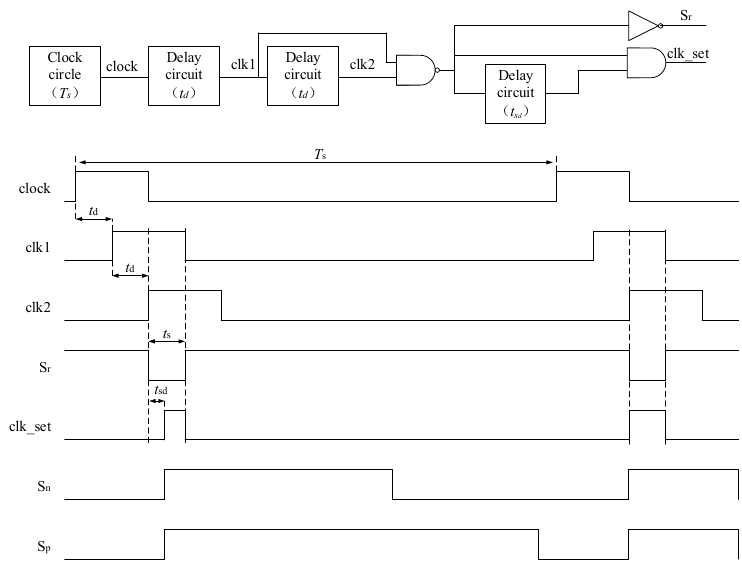
Figure 7. Improved one-cycle control waveform processing.